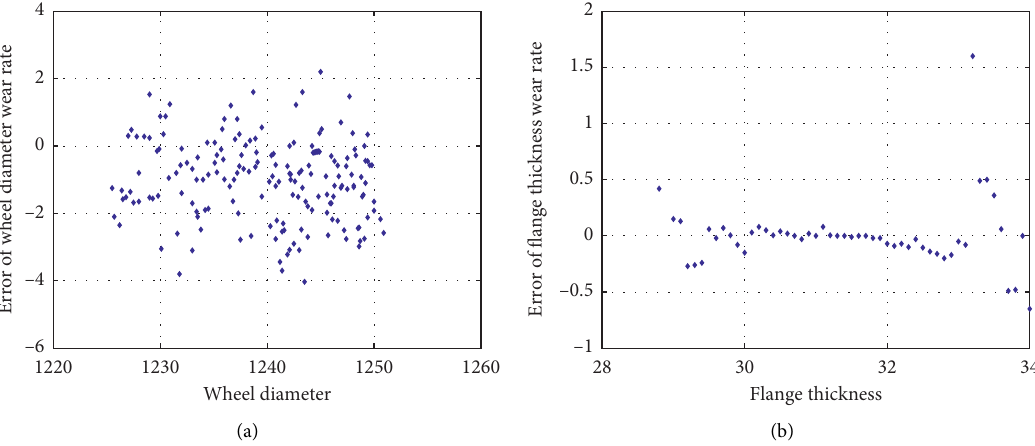
Figure 3: Error points chart of wear rate: (a) wheel diameter; (b) flange thickness.